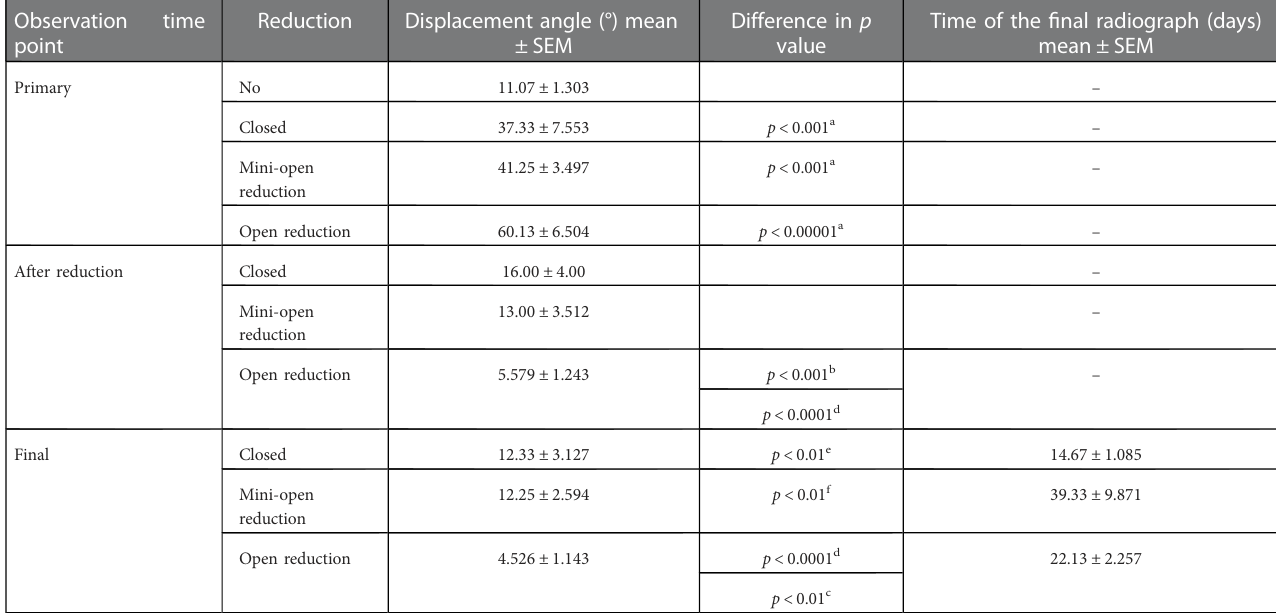
TABLE 1 Displacement angle on initial x-ray, after reduction, and fi nal in regard to treatment as mean±SEM and time of the fi nal radiograph in days as mean ±SEM. Observation